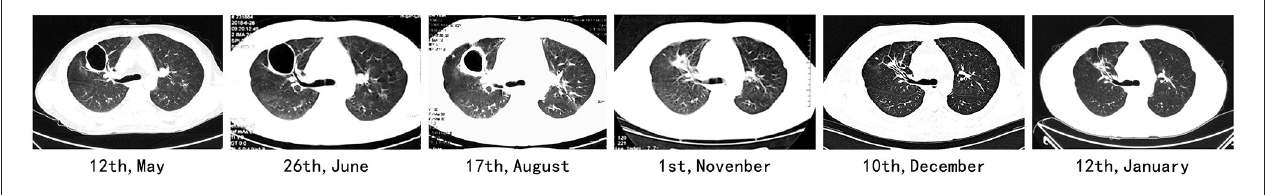
FIGURE 2 | Chest CT scans at follow